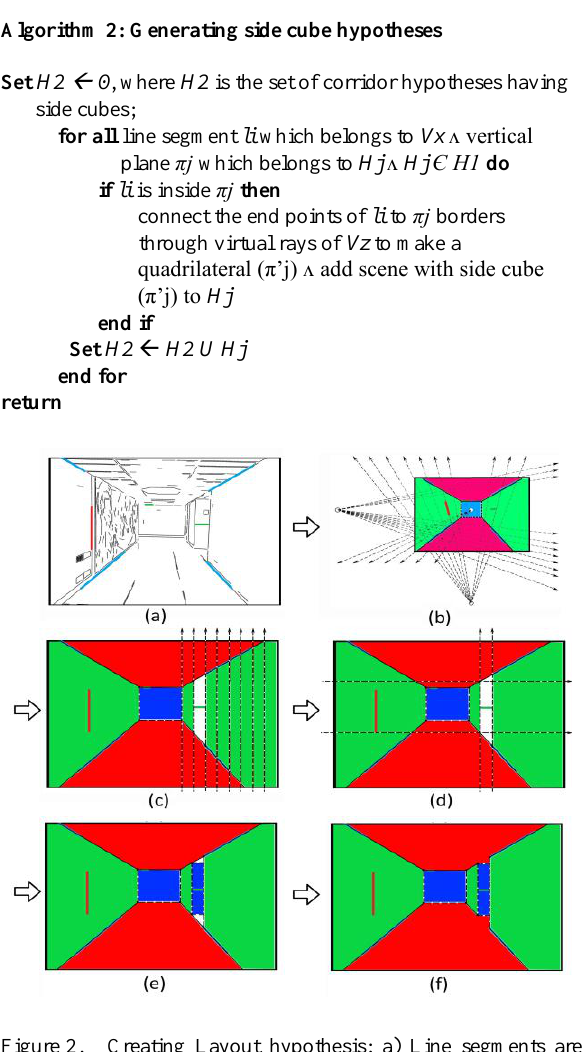
Algorithm 2: Generating side cube hypotheses